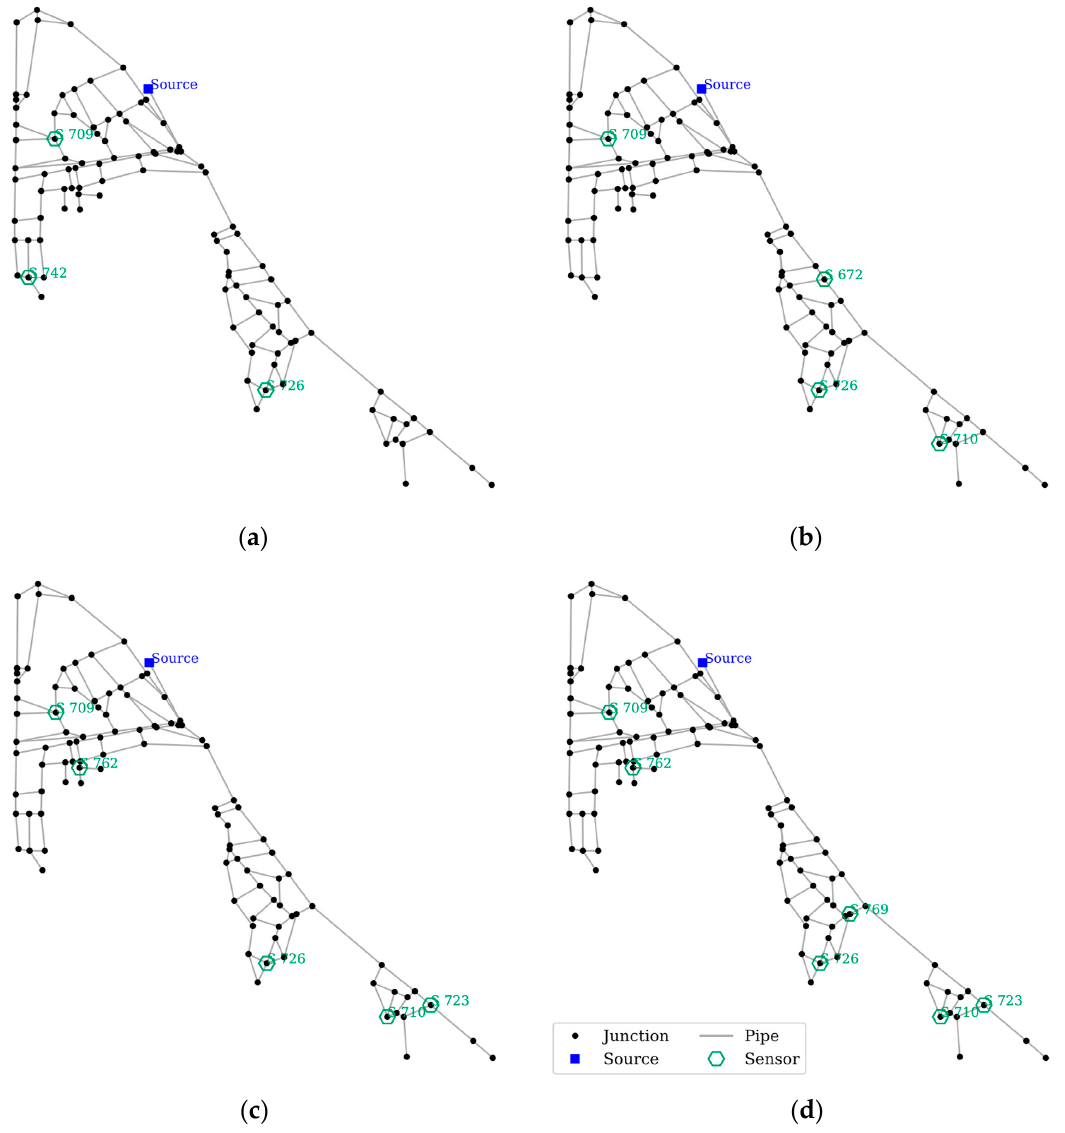
Figure 7. Sensor configuration for NET-A ( a ) Config-A, ( b ) Config-B, ( c ) Config-C, and ( d ) Config-D. Table 4. Performance comparison for NET-A.